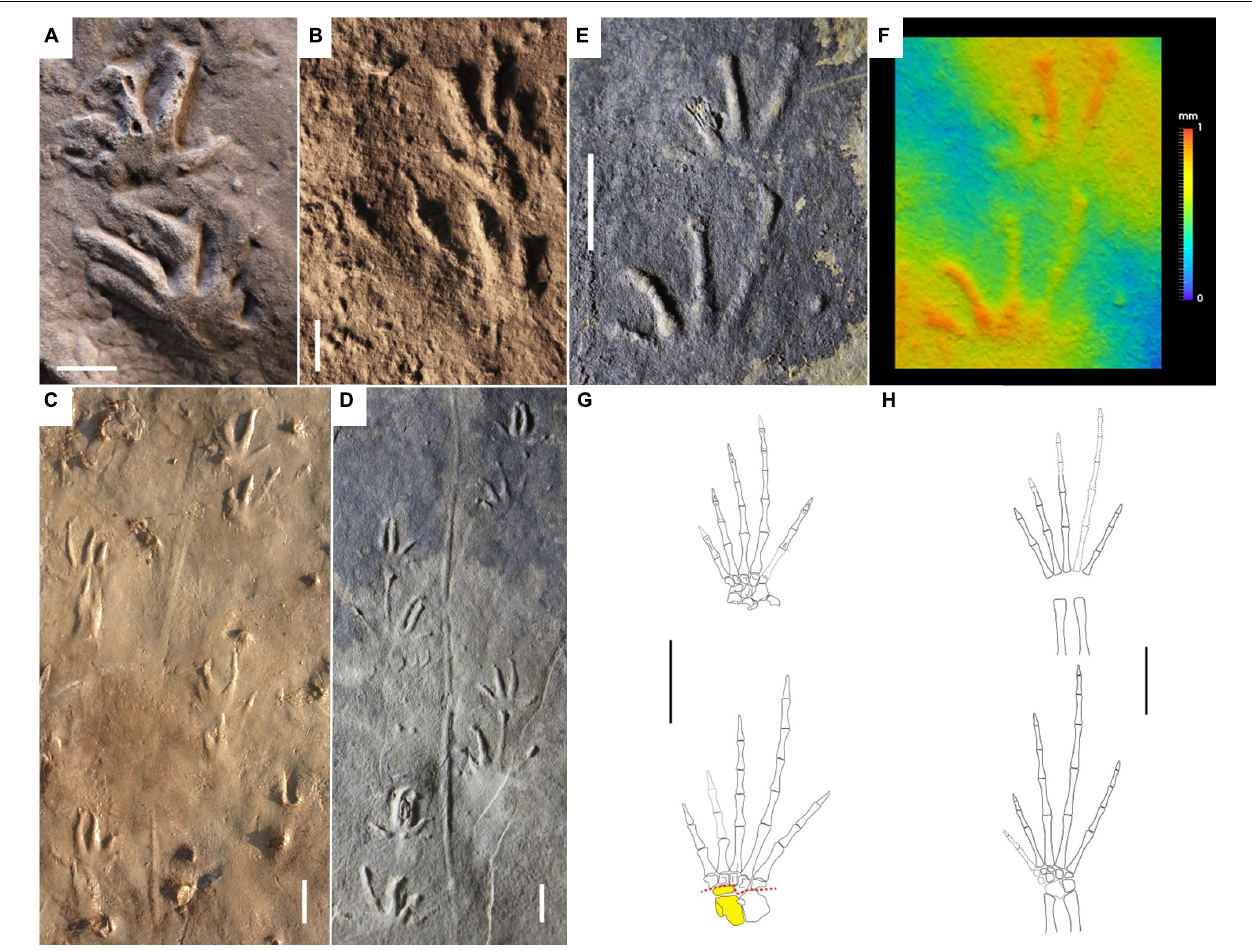
FIGURE 6 | Carboniferous reptile tracks and trackmakers: Notalacerta missouriensis (A–F) and basal reptiles (G,H) . (A) NSM 008GF031.068, left pes-manus impression, convex hyporelief. Joggins Formation, Nova Scotia. (B) KGS 1381. Right pes-manus couple, convex hyporelief. Rockcastle Sandstone Member, Lee Formation, Kentucky. (C) JL NN-1, trackway with tail impression, convex hyporelief. Pottsville Formation, Alabama. (D) NMMNH P-31746-7, trackway with straight tail impression, convex hyporelief. McAlester Formation, Oklahoma. (E) NMMNH-NN 2. Left pes-manus couple, convex hyporelief. McAlester Formation, Oklahoma. (F) False-color depth map of (E) . (G) Paleothyris acadiana , reconstruction of right pes and manus, dorsal side. From Carroll (1969), modified. Astragalus and lateral centrale in yellow (single block). Red dotted lines represent the possible articulations within the tarsus. (H) Anthracodromeus longipes , reconstruction of right pes and manus, dorsal side. From Carroll and Baird (1972), modified. Scale bars are 1